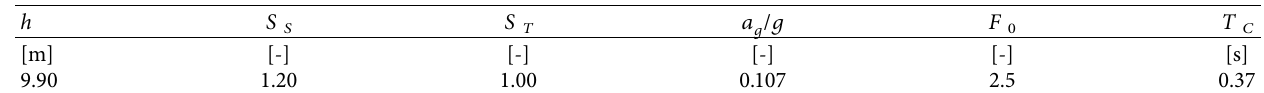
Figure 13: Supercinema: (a) architecture and (b) structure evidences. Table 1: Seismic